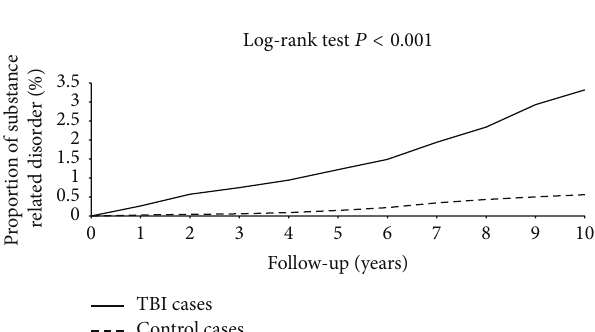
Figure 2: Cumulative incidence of substance related disorder among TBI (solid line) and control (dashed line) cases. TBI: trau- matic brain